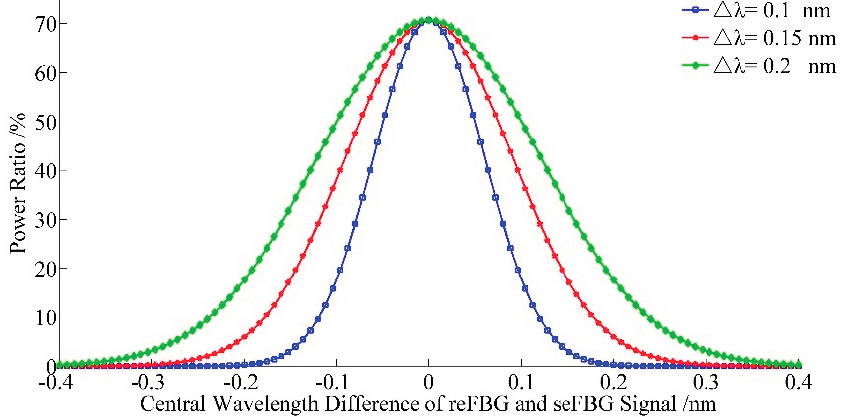
Figure 3. Relation between the power ratio and the central wavelength difference between the reFBG and seFBG while the FWHM of the seFBG and reFBG are